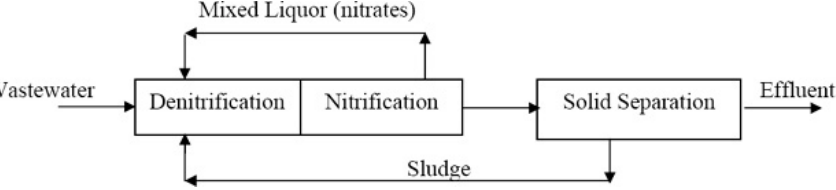
Figure 1. Simplified flow diagram of biological processes of the wastewater plant treatment of the city of Bologna, where samples used in this study were